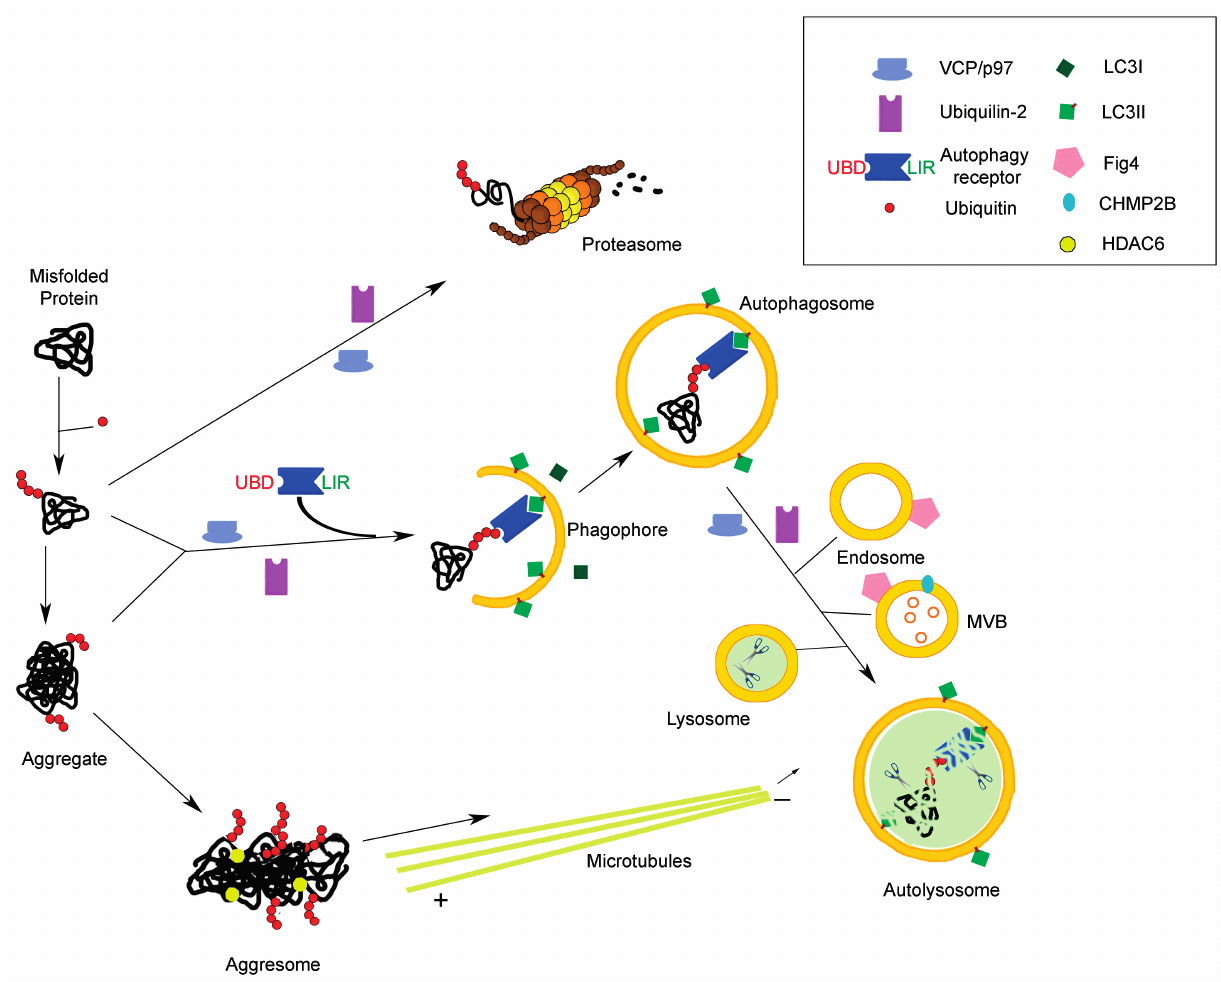
Figure 1. Molecular links between the two main protein degradation pathways in the cell: the proteasomal and autophagolysosomal systems. The cartoon illustrates the involvement of receptors/adaptors/chaperones common to both systems in the process of the degradation of misfolded proteins, as an example of a function highly relevant to neurodegenerative diseases, such as ALS. See the text for further explanation. UBD, ubiquitin-binding domain; LIR, LC3-interacting region; MVB, multivesicular